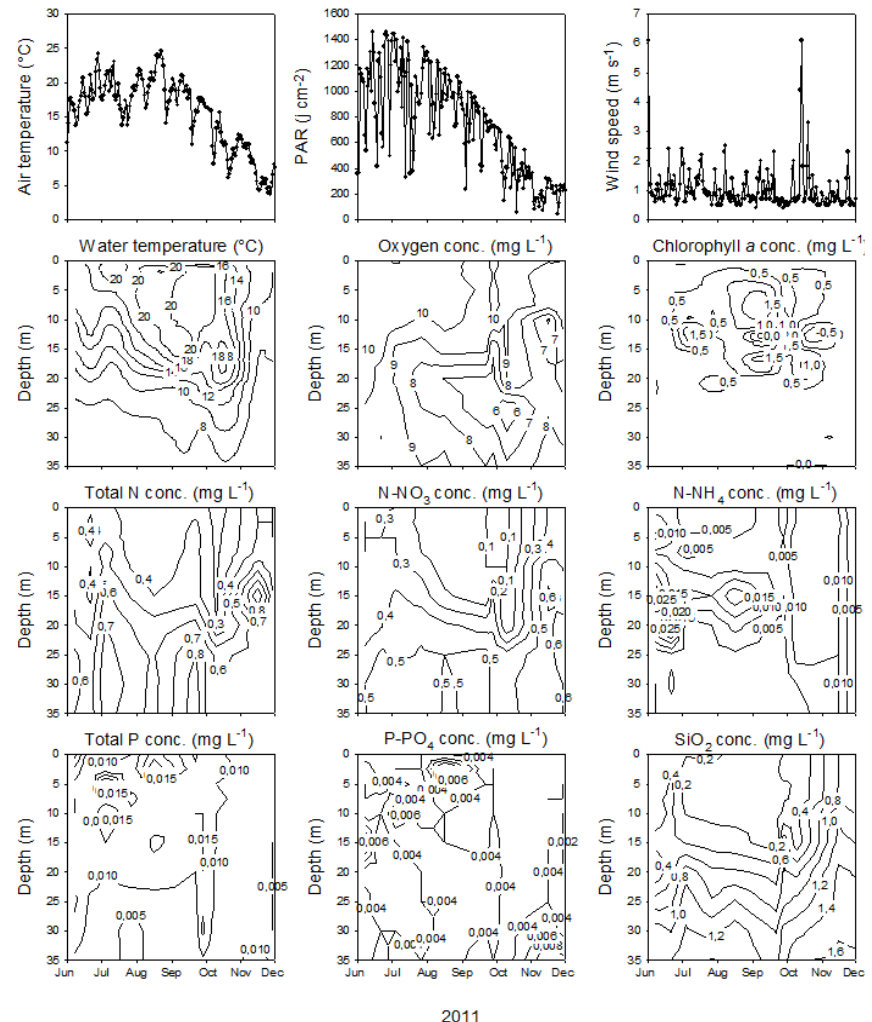
Fig. 1. Time series obtained for the main environmental parameters from June to December 2011 (A). The interpolation between the data was generated automatically by SigmaPlot 12.0. 711 oxygen concentration varied between 5.2 and 10.9 mg L − 1